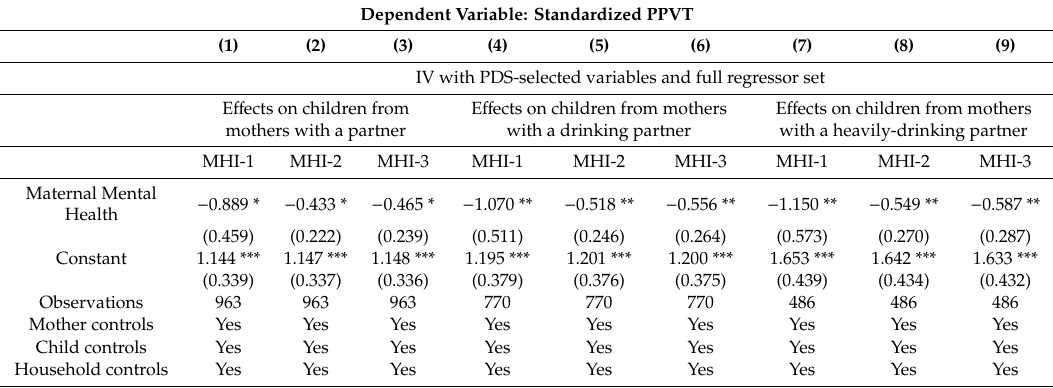
Table 7. Heterogeneous e ff ects of maternal mental health on children vocabulary at age 5 by the mother’s marital status and partner’s drinking behavior. Dependent Variable: Standardized PPVT IV with PDS-selected variables and full regressor set E ff ects on children from E ff ects on children from mothers E ff ects on children from mothers mothers with a partner with a drinking partner with a heavily-drinking partner MHI-1 MHI-2 MHI-3 Maternal Mental